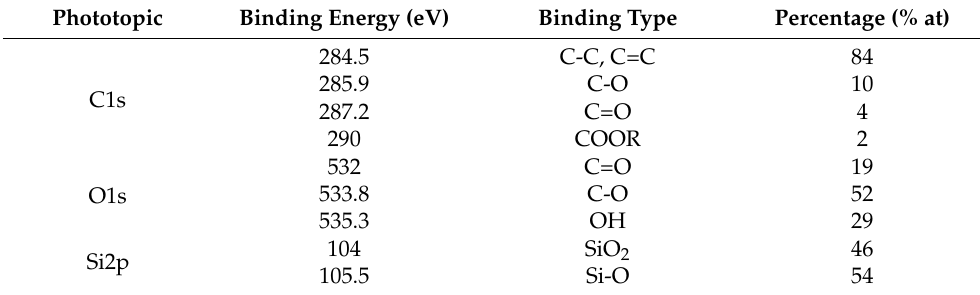
Table 1. Percentage surface composition of graphene nanofibers. Deconvolution of high-resolution XPS photopeaks.